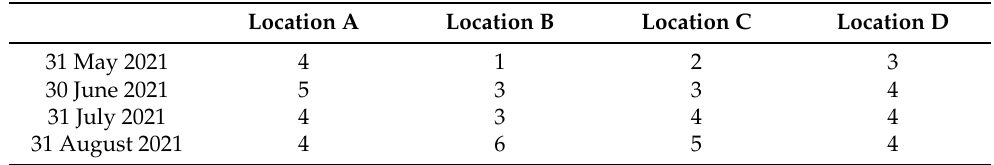
Table 5. The number of unique devices that appeared in the decision trees for each location and each split